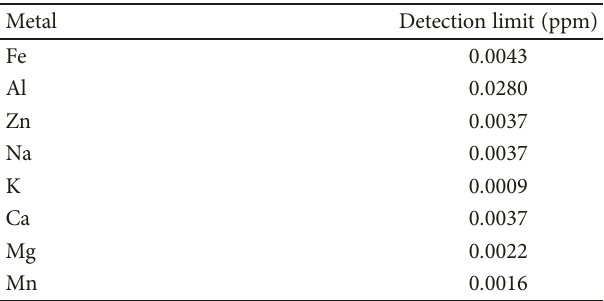
Table 2: Atomic absorption by fl